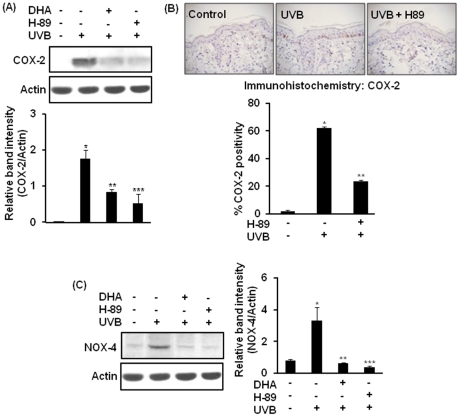
Role of MSK1 in UVB-induced expression of COX-2 and NOX-4 in mouse skin.Animals were treated topically with H-89 (25 nmol) or DHA (10 µmol) as described in Fig. 1 and sacrificed 6 h post irradiation. (A) Effect of H-89 or DHA on UVB-induced COX-2 expression was analyzed by Western blot analysis. *,
p<0.001 (control versus UVB); **,
p<0.01 (UVB versus 10 µmol DHA plus UVB); ***,
p<0.01 (UVB versus 25 nmol H-89 plus UVB). (B) Formalin-fixed skin tissues pretreated with H-89 and exposed to UVB radiation were subjected to immunohistochemical analysis. Positive COX-2 staining yielded a brown-colored product: acetone (left), UVB alone (middle), and UVB plus H-89, 25 nmol (right). Percent of COX-2 positivity in epidermal layer was determined by counting the number of total COX-2 positive cells from 10 equal sections of immunostained tissues from each animal. *,
p<0.001 (control versus UVB); **,
p<0.01 (UVB versus 25 nmol H-89 plus UVB). (C) Cell lysates were analyzed for NOX-4 by using western blotting. *,
p<0.001 (control versus UVB); **,
p<0.01 (UVB versus 10 µmol DHA plus UVB); ***,
p<0.01 (UVB versus 25 nmol H-89 plus UVB).